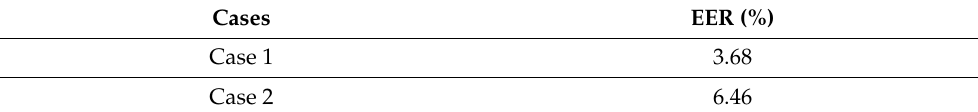
Table 11. Evaluation based on cross-database matching performance. Case 1 means the training of OSRCycleGAN for SR and ResNet-101 for ocular recognition with CASIA-Iris-Lamp database, and testing with CASIA-Iris-Distance database. Case 2 means the training of OSRCycleGAN and ResNet-101 with CASIA-Iris-Distance database, and testing with CASIA-Iris-Lamp database.